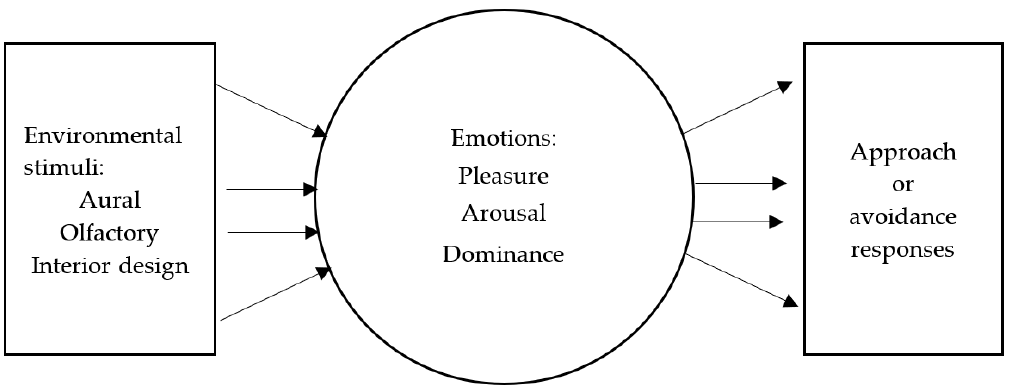
Figure 1. Store atmosphere effect model [8] .